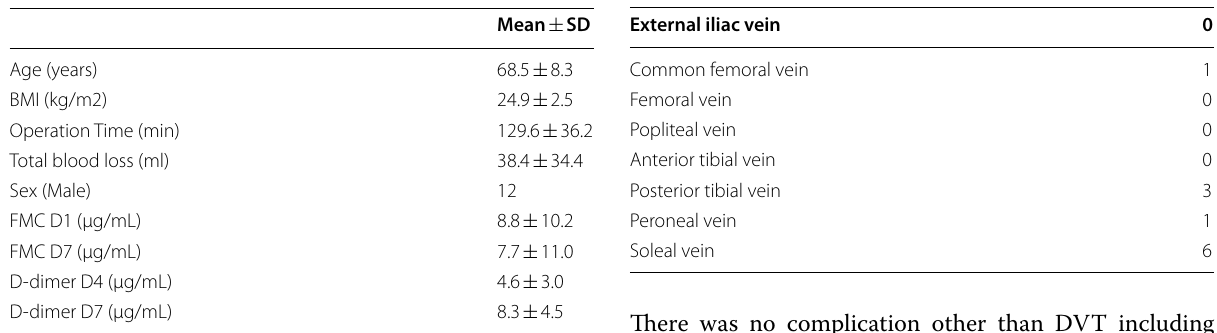
Table 4 Thrombus locations